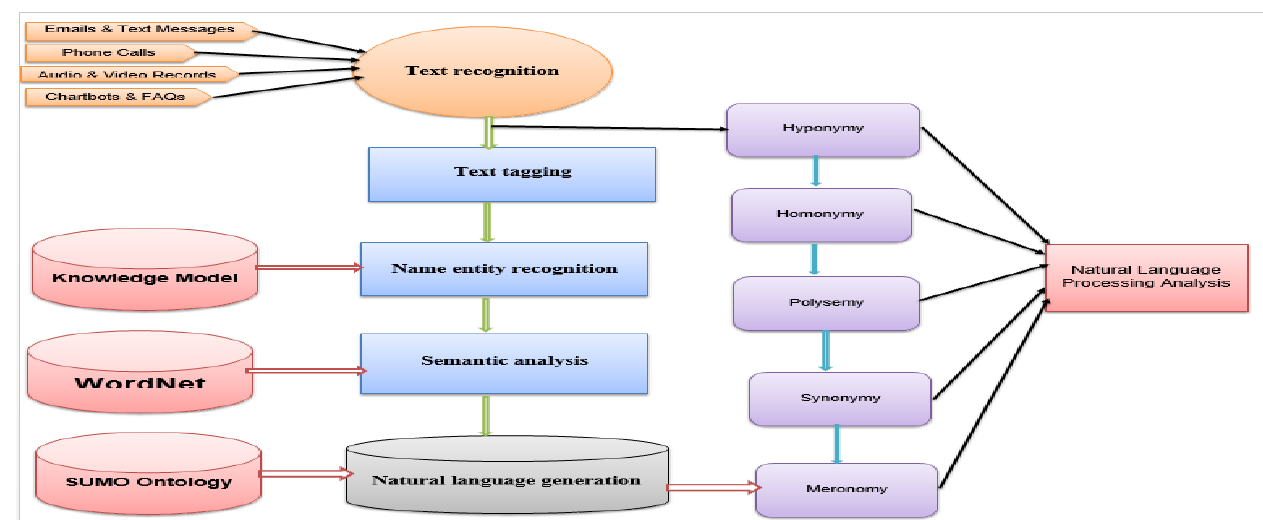
Figure 2. Aspects of NLP for modern business.